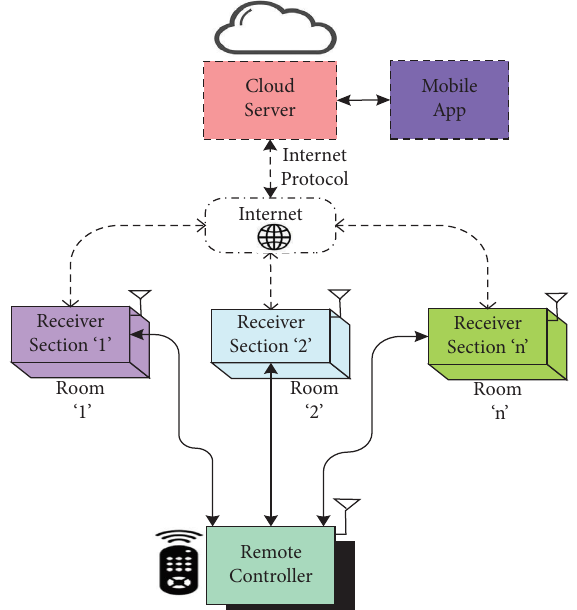
Figure 1: IoT-enabled architecture for remote controller.